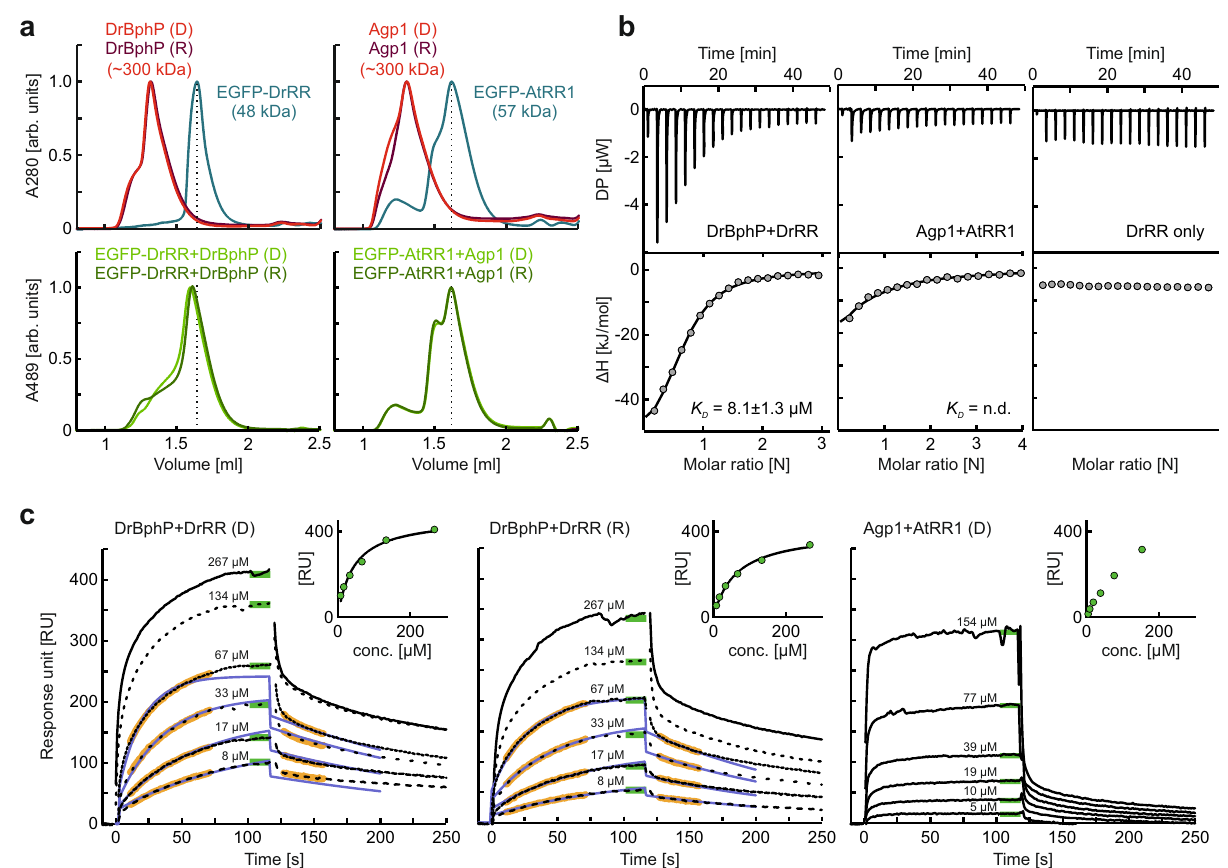
Fig. 2 Quantitative analyses of the BphP/RR interactions. a Size-exclusion chromatography (SEC) of the EGFP-labeled response regulators DrRR and AtRR1 in the absence (top) and presence (bottom) of DrBphP and Agp1, respectively. Vertical dashed lines indicate the retention volume of free RR monomer. Top panels: In isolation, EGFP-DrRR (45.4 kDa) and EGFP-AtRR1 (45.4 kDa) eluted as a monomer and a monomer/dimer mixture, respectively. DrBphP (84.0 kDa) and Agp1 (83.8 kDa) are known to be dimers, and their apparently high molecular weights (~300 kDa) can be explained by the poor resolution of large proteins in the conditions. Bottom panels: When combined with DrBphP in its dark-adapted state (D) or after 655-nm illumination (R), the pro fi le for EGFP-DrRR shifted to shorter retention times, indicative of interactions. By contrast, addition of Agp1 had little effect on the retention of AtRR1. The top panels are plotted at 280 nm and the bottom panels at 489 nm. The A489 signals from BphPs were negligible. b Isothermal titration calorimetry (ITC) measurements. Differential power (DP) resulting from injections of the response regulator to the BphP is plotted against time, and the binding enthalpy ( Δ H) is plotted against the molar ratio of the proteins. See Supplementary Fig. 2 for additional data and control measurements. c Surface plasmon resonance (SPR) measurements. The response regulators were coupled on the sensor surface, and varying concentrations of the corresponding phytochrome were applied in darkness (D) or after red-light illumination (R). The sensorgrams (black lines), the kinetic fi ts (blue lines), and the parts of the data that were used for kinetic analysis (orange) are indicated. For kinetic analyses, DrBphP concentrations of 8 – 67 µ M were used. Green lines mark the R eq values that were used for evaluating the steady-state af fi nity data, shown in Supplementary Fig. 2i. Inset: Steady-state fi t of the concentration series, where R eq values were used for af fi nity approximation. See Supplementary Fig. 2i for a table of SPR fi tting values. Source data are provided as a Source data fi